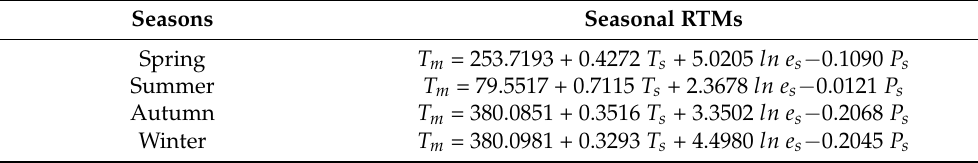
Table 7. Seasonal three-factor linear RTMs during 2015–2016.